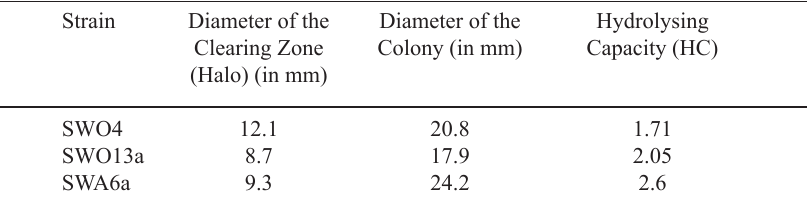
Table 3. The results of screening tests in Congo Red Agar. The Diameter of the Clearing Zone and that of the Colony are shown. The HC gives an estimation of the cellulolytic potential of the three strains Strain Diameter of the Diameter of the Hydrolysing Clearing Zone Colony (in mm)